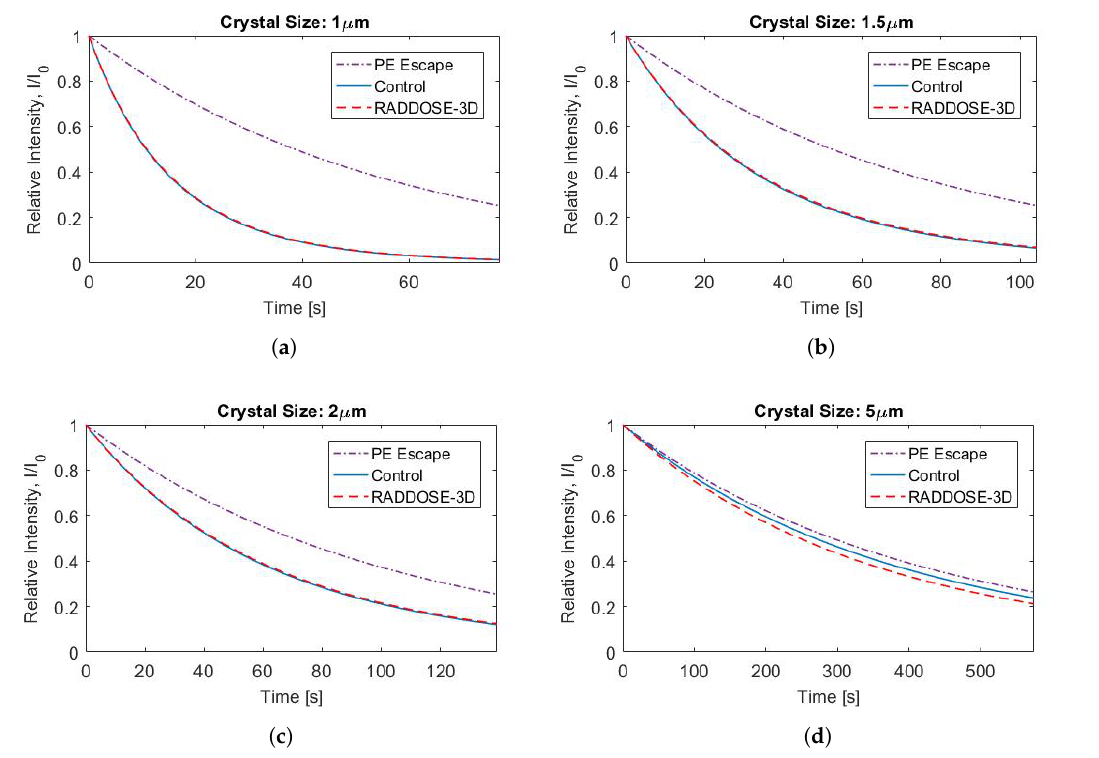
Figure 1. Relative intensity, I / I 0 , as a function of time, for a 3Å Bragg spot for crystal size: ( a ) 1µm; ( b ) 1.5µm; ( c ) 2µm; and ( d ) 5µm. Each crystal is assumed to be centred in a 12keV beam with incident flux of 1 × 10 10 photonss −1 and a beam FWHM matched to the crystal size. Three sets of dose maps were used in the simulations: Purple dot-dash lines and solid blue lines show results based on our simulated dose maps (see Section 4.5). The former accounted for PE escape, the latter (control) did not; both accounted for Compton scattering. Our model that accounted for PE escape also included the effect of PEs being scattered into the crystal from the solvent. Dashed red lines show results based on RADDOSE-3D [9] dose maps; the version used did not account for either PE escape or Compton scattering. The discrepancy between the simulation that accounts for PE escape and those that do not becomes more significant as the crystal size decreases from 5µm to 1µm. No significant variation is observed between the two simulations that did not account for PE